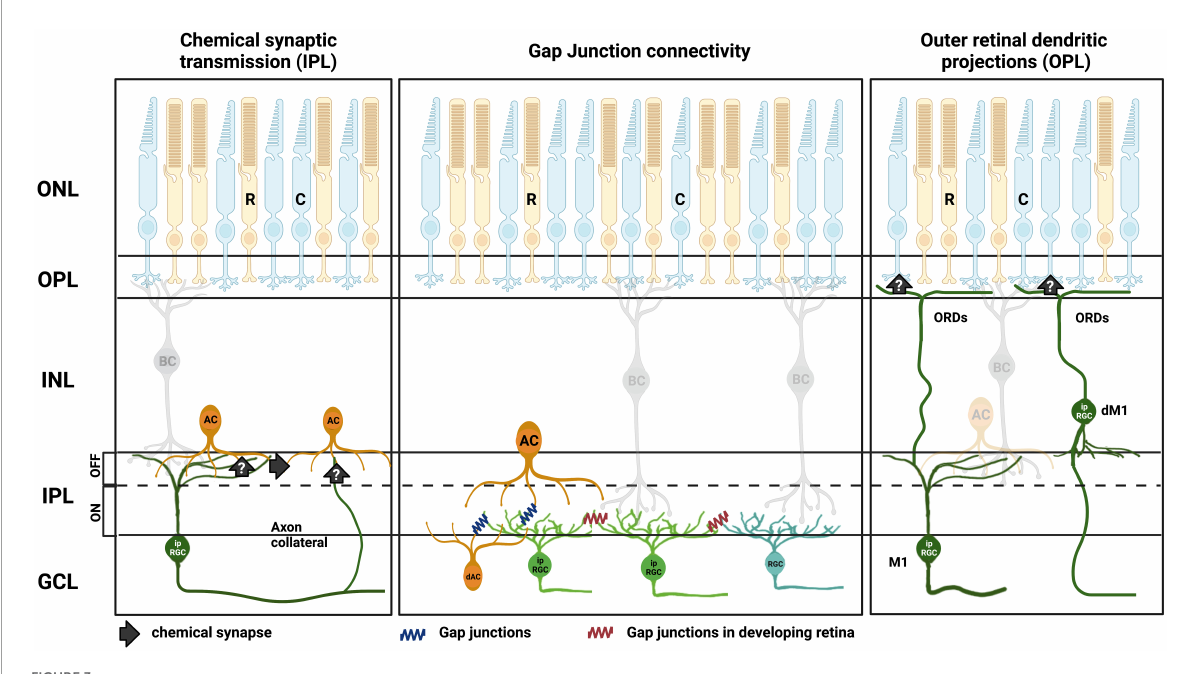
FIGURE3 Summary of ipRGC intraretinal signaling routes in the retina. (Left) Chemical synaptic transmission to amacrine cells (AC) is either direct, via axon collaterals (Joo et al., 2013), or indirect via intermediary amacrines. (Middle) Direct gap junction connection of ipRGCs to amacrine cells in the GCL and INL in adult retina. Direct gap junction connection of ipRGC to amacrine cells (Muller et al., 2010; Reifler et al., 2015; Harrison et al., 2021; Pottackal et al., 2021), and ipRGC to ipRGCs and non-ipRGCs, during retinal development (Arroyo et al., 2016; Caval-Holme et al., 2019). (Right) Putative synaptic inputs to cone photoreceptor terminals in the OPL via outer retinal dendrites (ORDs) from M1 ipRGCs (Renna et al., 2015; Sondereker et al., 2017). Outer nuclear layer (ONL), outer plexiform layer (OPL), inner nuclear layer (INL), inner plexiform layer (IPL), ganglion cell layer (GCL), rods (R), cones (C), bipolar cell (BC), displaced amacrine cell (dAC), displaced M1 ipRGC (dM1). Created with